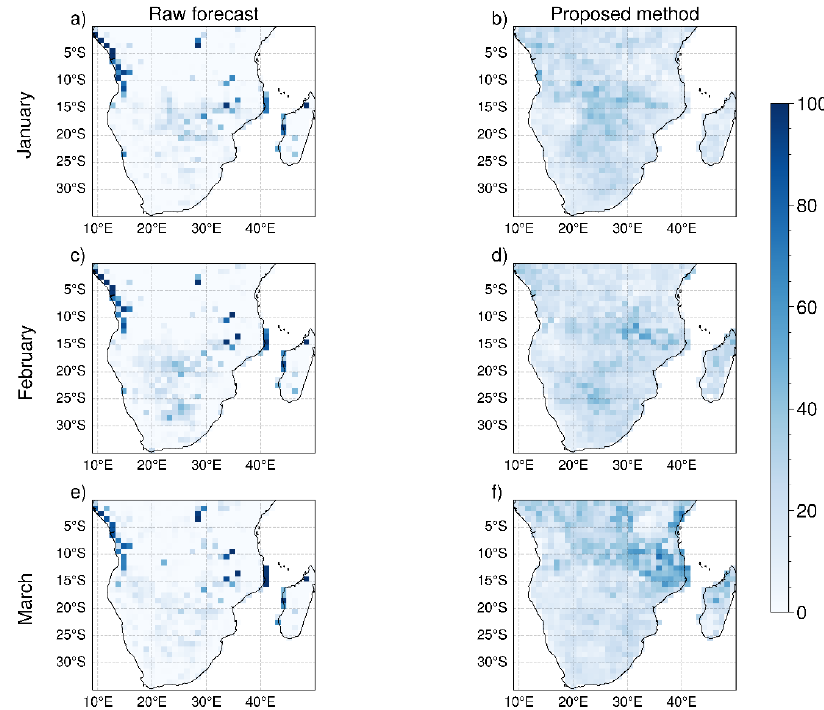
Figure 9. Spatial distribution of average percentage of ensemble members that correctly predict extreme events defined as the values of 2 m mean temperature exceeding the 99th percentile: raw data ( a , c , e ) and bias-corrected data ( b , d , f ). The maps refer to seasonal forecast System 7 (Météo-France). Results are shown for the three months (row-wise) and lead time one.